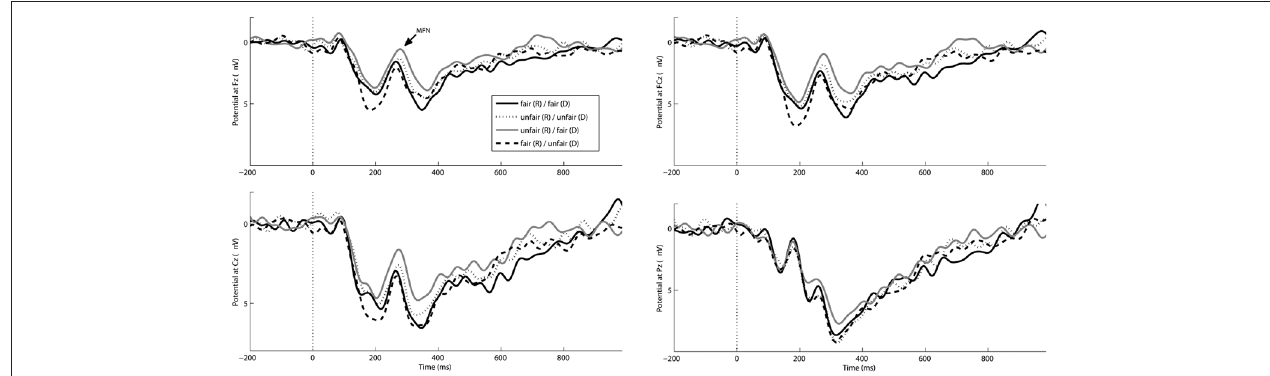
FIGURE 2 | Grand average ERP waveforms at Fz, Fcz, Cz, and Pz for the offers: fair/fair (solid line), fair/unfair (dashed line), unfair/fair (gray line), or unfair/unfair (dotted line). Negative is plotted up, Zeros on the timeline indicate the onset of the offer; format: